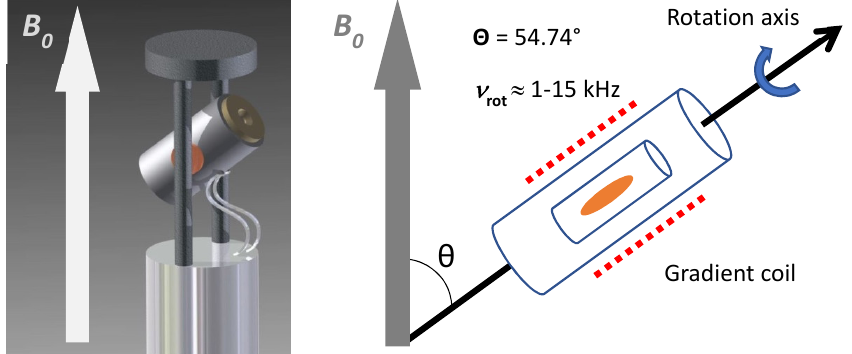
Figure 1. Representation of an HR-MAS NMR probe head with an orientation of the stator at an angle (θ) of 54.7° between axis of rotation and B 0 . The rotation speed (v rot ) of the sample reaches up to 15 kHz. A gradient coil is arranged around the rotor.